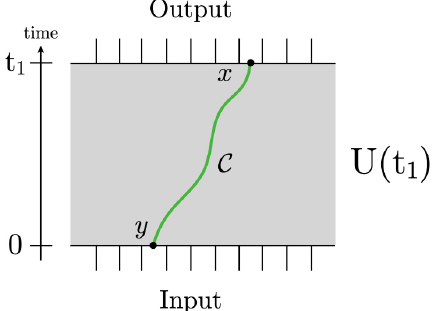
Figure 5 . A curve C that divides the unitary circuit into two parts. In the line-tension picture, the entanglement entropy S ( x, y, t ) is given by the integral of the line tension T ( v ) along the U 1 curve C